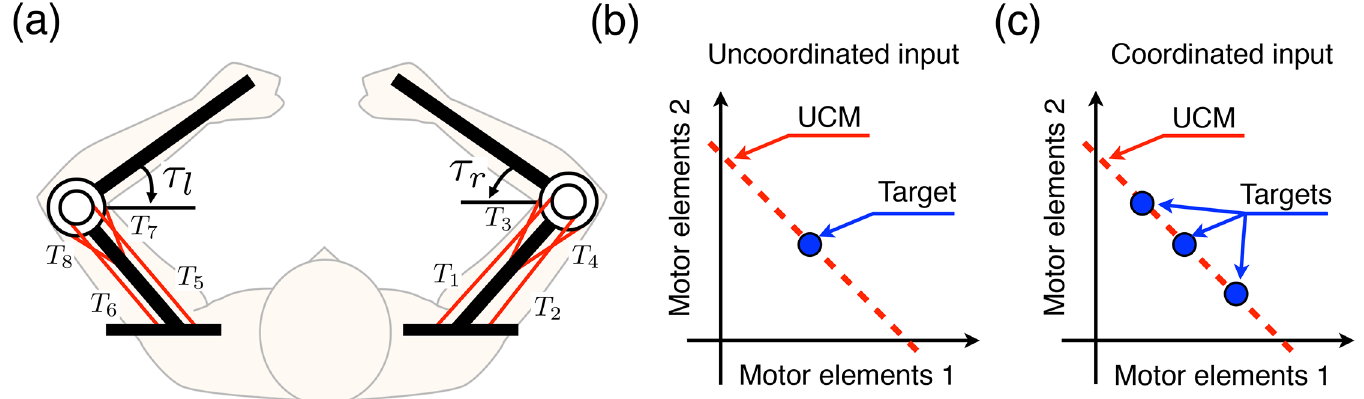
Fig 3. Human elbow model used in the simulation experiments. (a) The two elbow joint, eight muscle model. The four muscle tensions ( T 1 – T 4 ) generate the right elbow joint torque τ r , and the others ( T 5 – T 8 ) generate the left elbow joint torque τ l . The muscles T 3 , T 4 , T 7 , and T 8 are the monoarticular muscles, and the others are the biarticular muscles. (b) The uncoordinated input corresponds to one point in the UCM. (c) The coordinated input corresponds to three points in the UCM.